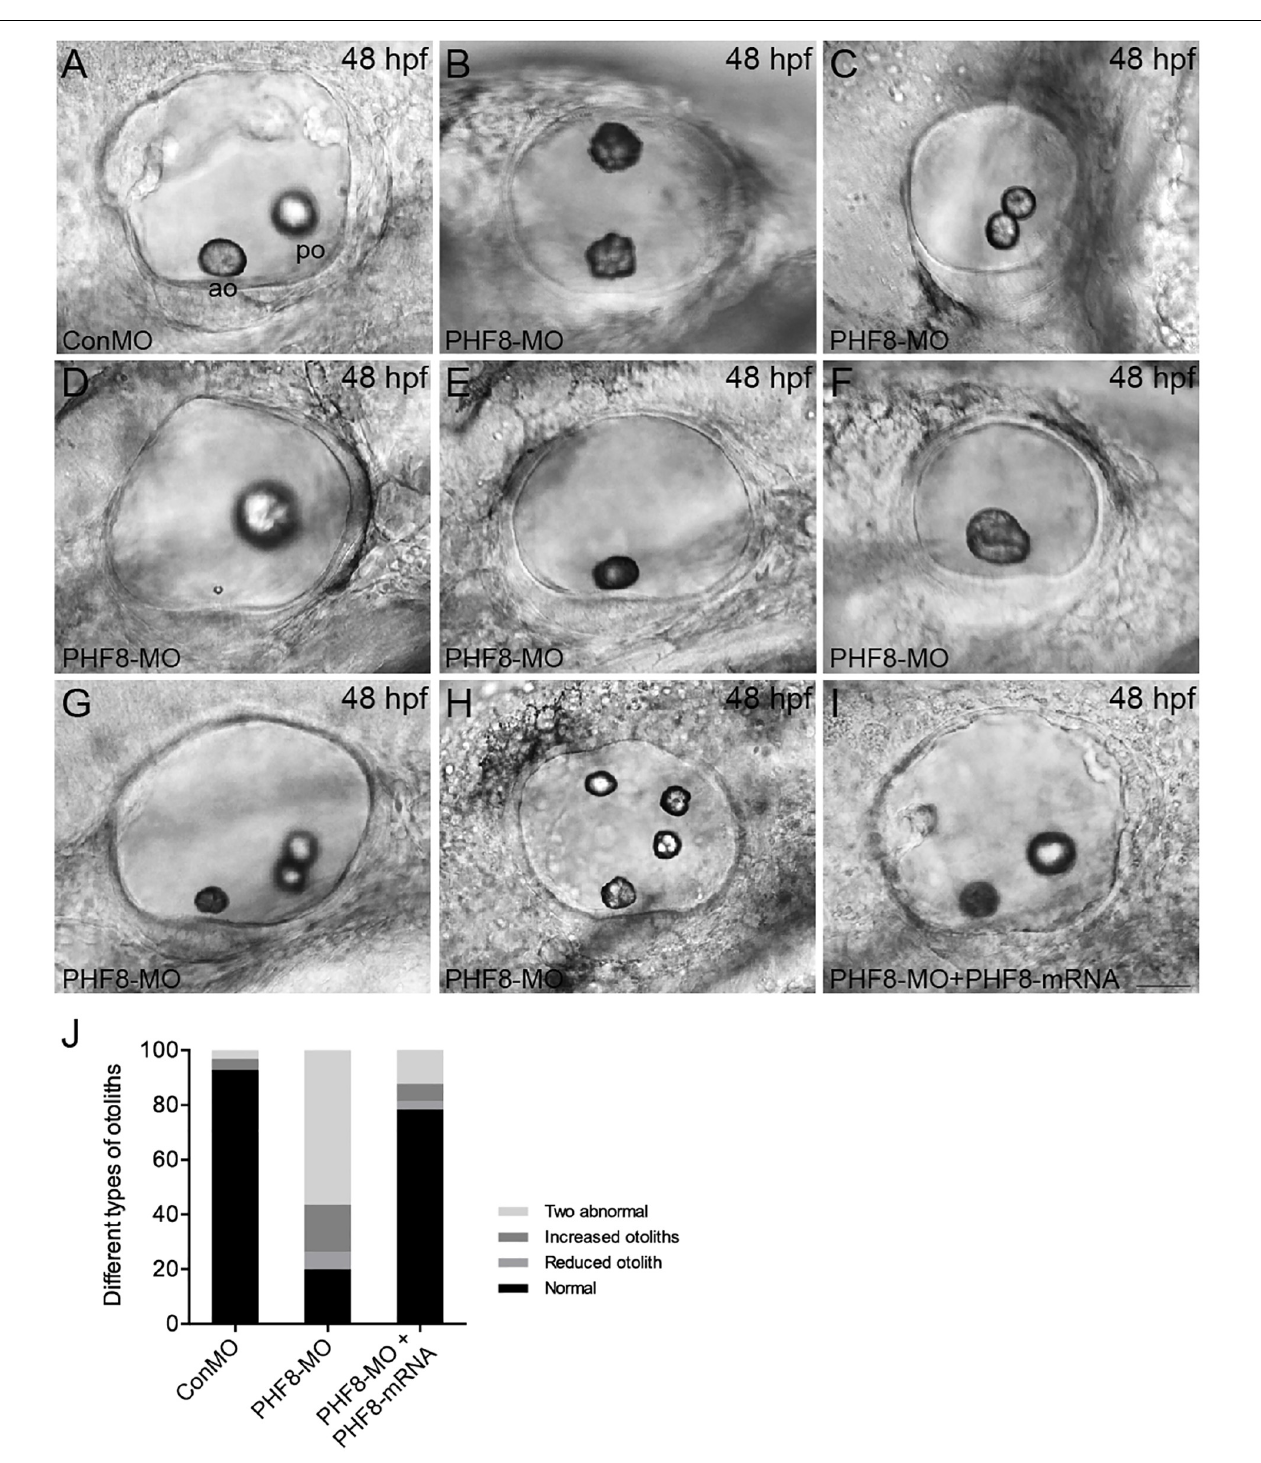
FIGURE 6 | Analysis of otic vesicle formation in PHF8 morphant. (A–I) The overall morphology of otic vesicles in control embryos (ConMO; A ), PHF8 morphants (PHF8-MO; B–H ), and PHF8-MO co-injected with PHF8-mRNA embryos (PHF8-MO + PHF8-mRNA; I ) at 48 hpf. According to the otolith phenotypes, zebrafish PHF8 morphants were divided into types as follows: the 2 abnormal otolith groups ( B , misplaced; C , fused; D , tiny); the 1 otolith group (E,F) ; and the multiple otolith group (G,H) . (J) Statistical results of different kinds of malformed otoliths ( n = 125 for ConMO embryos, n = 126 for PHF8 morphants, and n = 75 for PHF8-MO + PHF8-mRNA embryos). The positions of the anterior otolith (ao) and posterior otolith (po) are implied. Optical appearances elucidate lateral visions; anterior is on the left. Scale bar, 25 µ m.